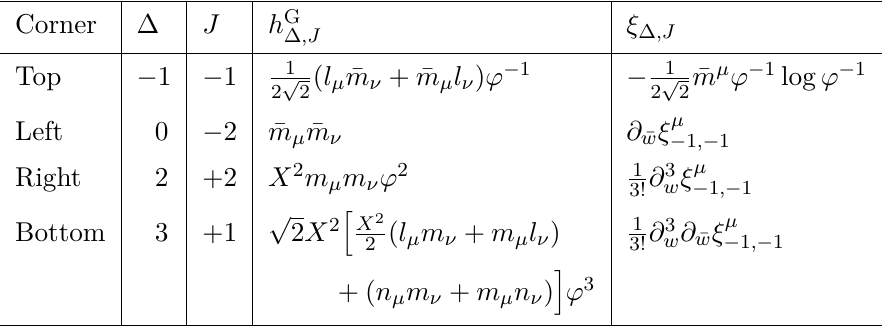
Table 18. Elements of the celestial diamond corresponding to superrotation symmetry.